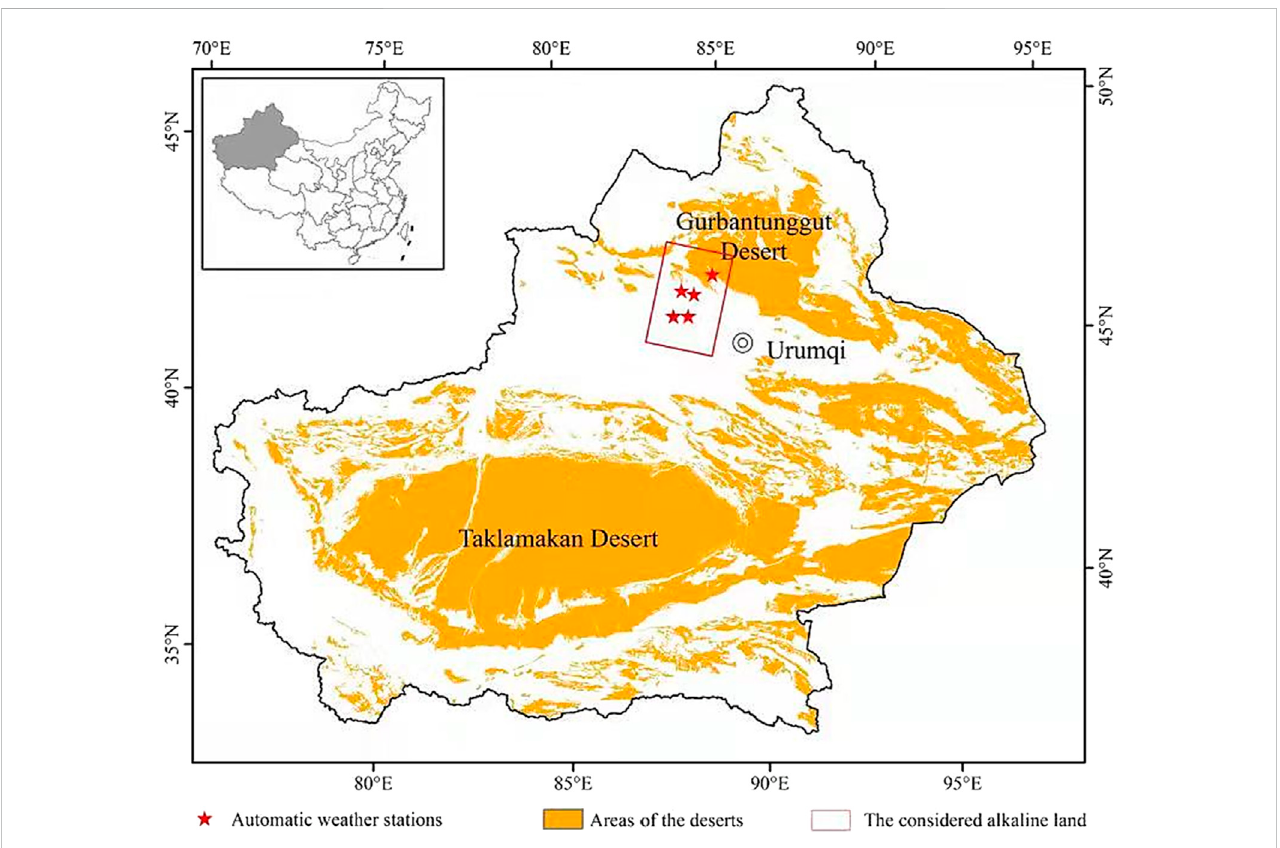
FIGURE 1 Spatial distribution of the fi ve automatic monitoring stations where the meteorological, soil and subterranean data are collected for the present study.